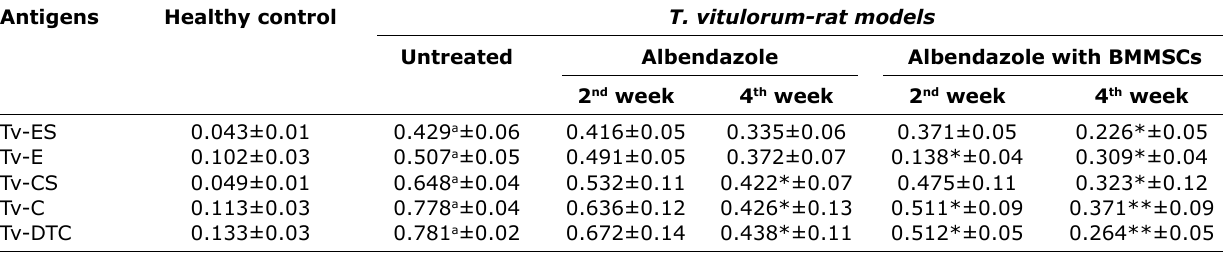
Table-2: Immunoglobulins against Tv-ES, Tv-E, Tv-CS, Tv-C, and Tv-DTC antigens in the serum of healthy control, untreated and treated T. vitulorum -rat models (OD).